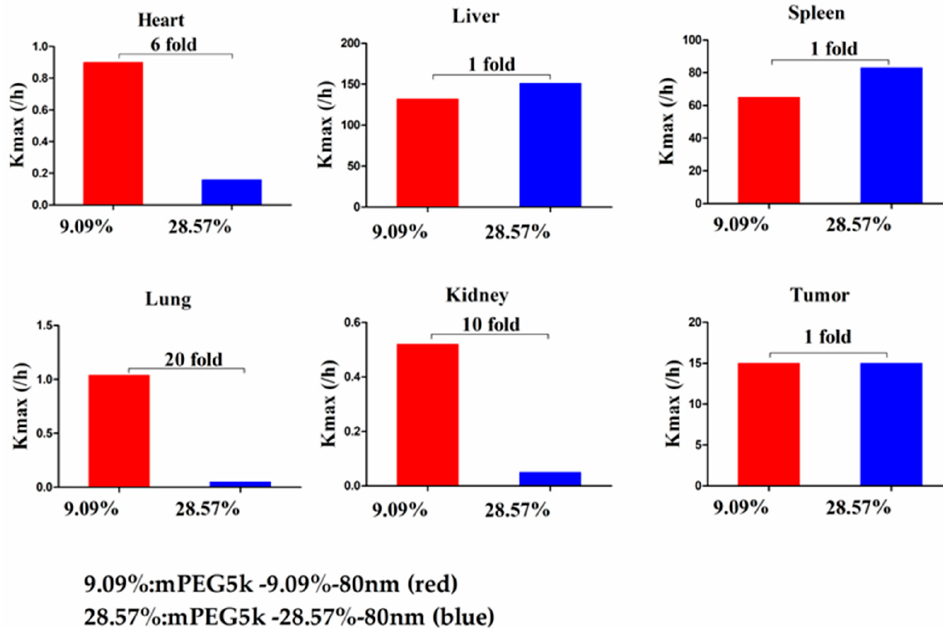
Figure 14. K max (/h) for mPEG5k-9.09%-80 nm (red) and mPEG5k-28.57%-80 nm NPs (blue).